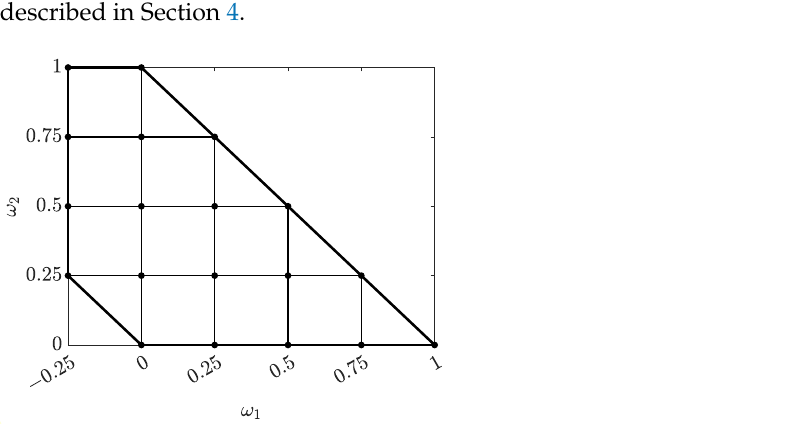
Figure 8. The illustration of the design space with 19 initial design points. The bold black lines show the design space of the optimization problem, while the black dotted points are the 19 design points in the design of